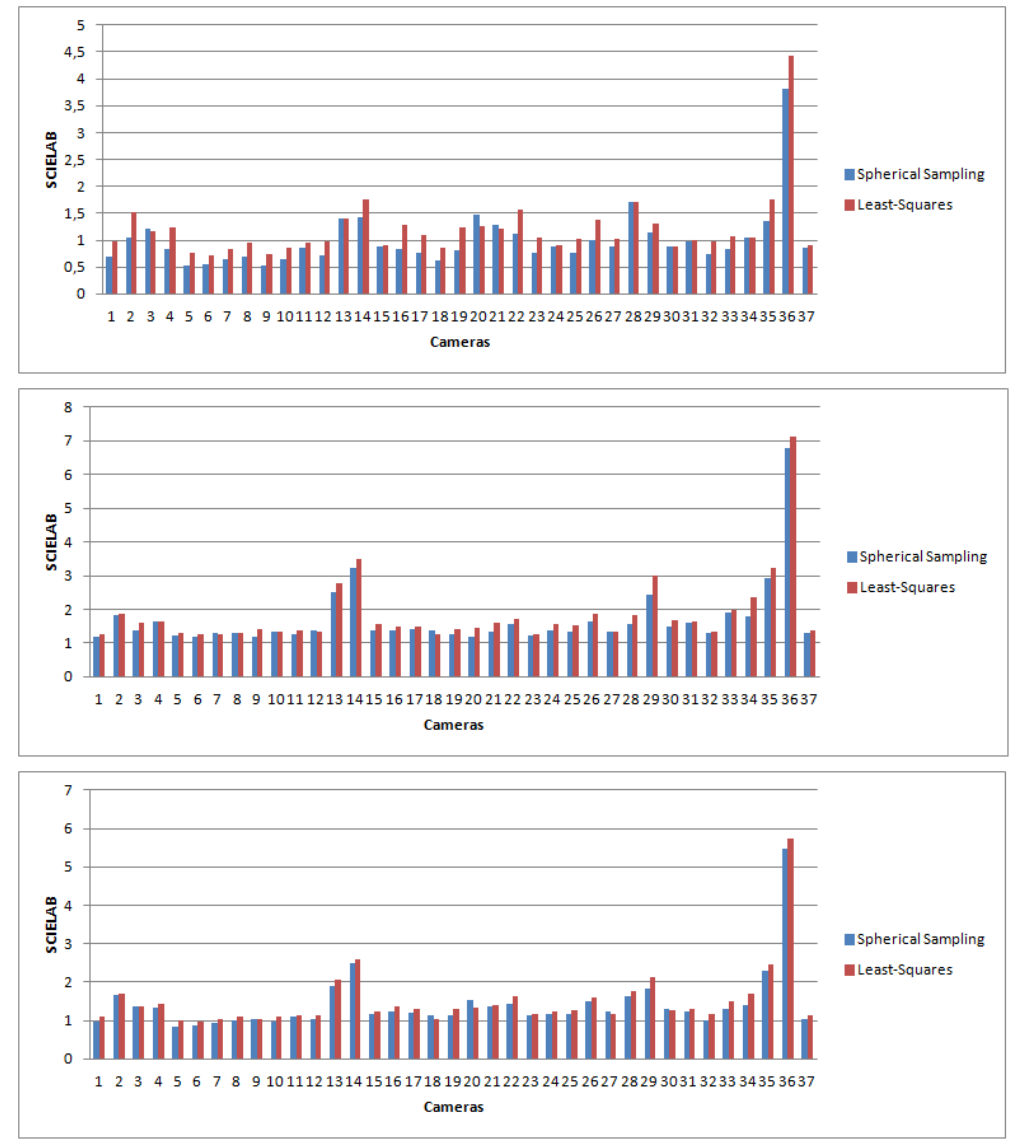
Figure 11. S-CIELAB error for the different cameras computed as the mean for the different images. In blue: S-CIELAB error for spherical sampling; in red: error for the least-squares minimization. ( Top ) First dataset; ( middle ): second dataset; ( bottom ) third